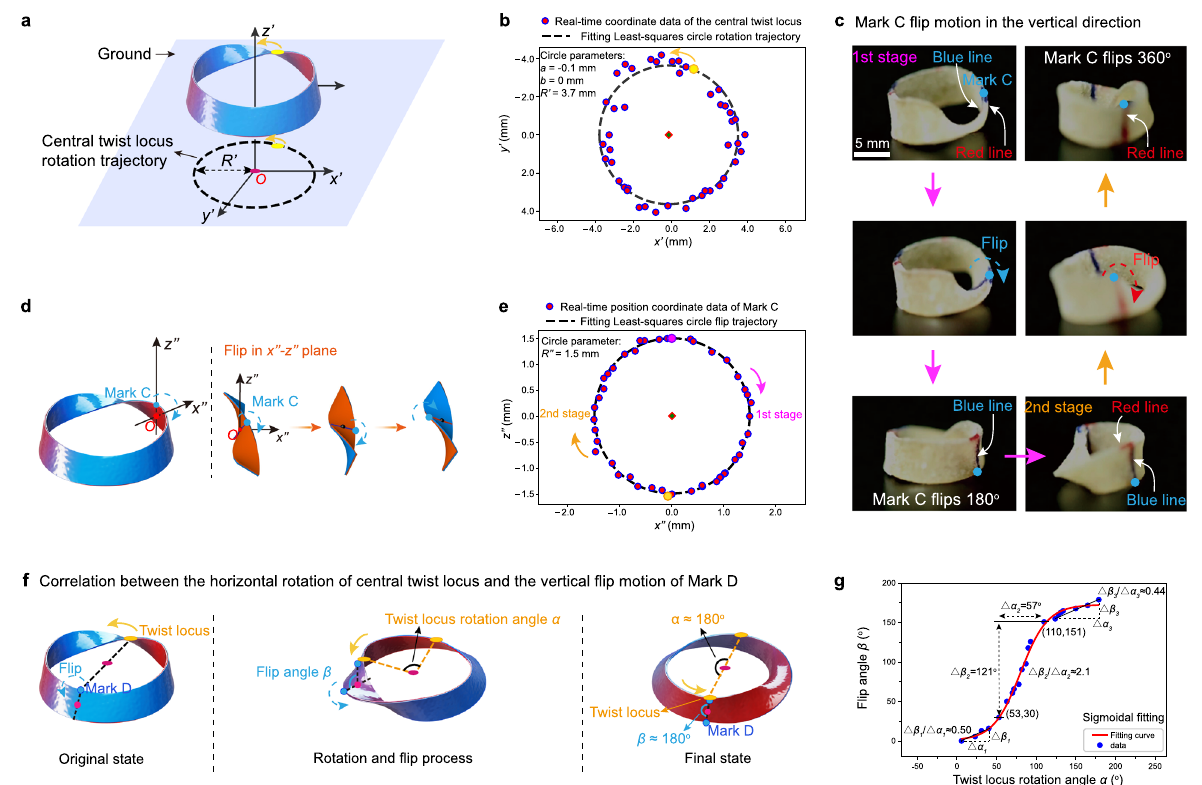
Fig. 7 Statistical analysis of the motion dynamics of the C-Möbius[ + 1] actuator. a Schematic illustration of the rotation of the locus of twist point projected in the x ’ -y ’ coordinates. The colour gradient from red to blue represents the contraction capability gradient (the red and blue parts indicate high and low contraction capabilities, respectively, same as in ( d , f )). b Rotation trajectory of the locus of twist point of the C-Möbius[ + 1] actuator (all scatter spot data were recorded every 3 s). c Photographs of the fl ip of the blue/red lines normal to the longitudinal direction of the strip (scale bar: 5 mm). Supplementary Movie 11 shows the scenario in motion. d Diagrammatic drawing of the fl ip motion of the C-Möbius[ + 1] actuator in the x ” -z ” plane. e The position coordinates of the point denoted mark C of the C-Möbius[ + 1] ribbon actuator recorded along a circular trajectory (all scatter spot data were recorded every 2 s). f Schematic illustration of the correlation between the rotation of twist (yellow point) and the turning motion of the point mark D (blue point). g Flip angle β as a function of the twist locus rotation angle α and Boltzmann model fi To further understand the motion dynamics of the C-Möbius rotation, the inner and outer lines changed to red and blue lines, [ + 1] actuator, the motion paths of the points at the rim of the C- and mark C rotated 180° During the second circle rotation, the Möbius[ + 1] band were tracked and analysed. First, the locus of outer blue line rotated to the inner surface, and mark C returned twist point (yellow point) of the C-Möbius[ + 1] actuator was to the original position after completing a 360° rotation. To projected in the horizontal x ′ - y ′ plane, as illustrated in Fig. 7a. dissect the rotation statistically, the position coordinates of mark The central twist point would return to the original position after C relative to midpoint O of the width of the Möbius strip were 720° anticlockwise rotation. The real-time coordinate data of the analysed and are plotted in Fig. 7d. We set the midpoint O of the central twist point were recorded for fi tting the circle by using the width as the origin (0, 0) in the vertical x ′′ - z ′′ plane and recorded least-squares method. Figure 7b indicated that the locomotion of the relative position coordinates of mark C during the rotation, the central twist point nearly followed a circular trajectory, which which con fi rmed that the point on the ring edge was capable of is presented in Eq. (1) moving along a roughly circular trajectory in the x ′′ - z ′′ plane (Fig. 7e and Supplementary Movie 11). Furthermore, when mark C completed a 360° rotation, the locus of twist would have undergone two 360° rotation circuits. The fl ip circle trace was where the radius R ’ is 3.7 mm, and parameters a and b are − 0.1 obtained by using Eq. (2) based on the least-squares method, and mm and 0 mm, respectively. It is worth noting that the the trace radius R ” was calculated as 1.5 mm. photothermal conversion effect induced a longitudinal contrac- tion of the soft LCE ribbon, and subsequently resulted in the signi fi cant decrease of the radius of the motion trace in Third, the correlation between the horizontal rotation of the comparison with that (4.8 mm) of the original C-Möbius[ + 1] locus of twist point and the vertical fl ip motion of a speci fi c point actuator. on the twisted band was investigated. As shown in Fig. 7f, the locus of twist point is marked in yellow, mark D is a point on the edge of the twisted band passing through the C2 symmetry axis plane, angle α is de fi ned as any speci fi c rotation angle of the locus of twist point in the horizontal plane, and angle β is de fi ned as the fl ip angle of mark D in the vertical plane. As the anticlockwise the blue line and red line. Figure 7c shows that in the fi rst circle